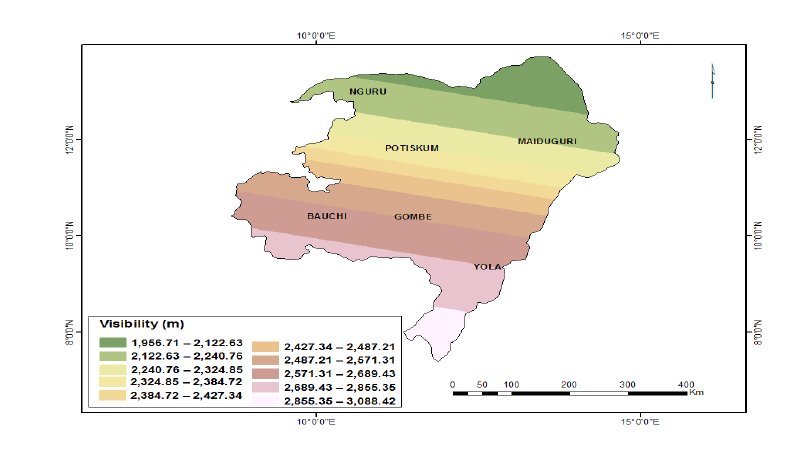
Figure 13: Spatial Air Visibility Distribution in Northeastern Nigeria (2004/2005 – 2008/2009).